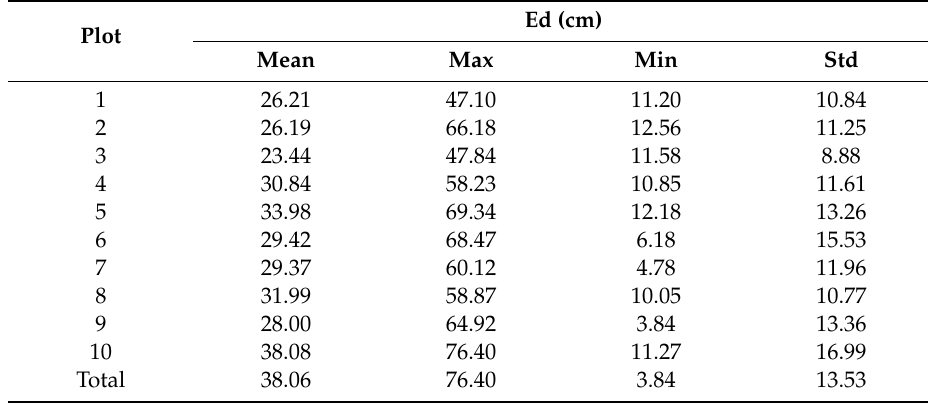
Table 5. Summary statistics of the error of the distance (Ed) between the estimated point and the reference